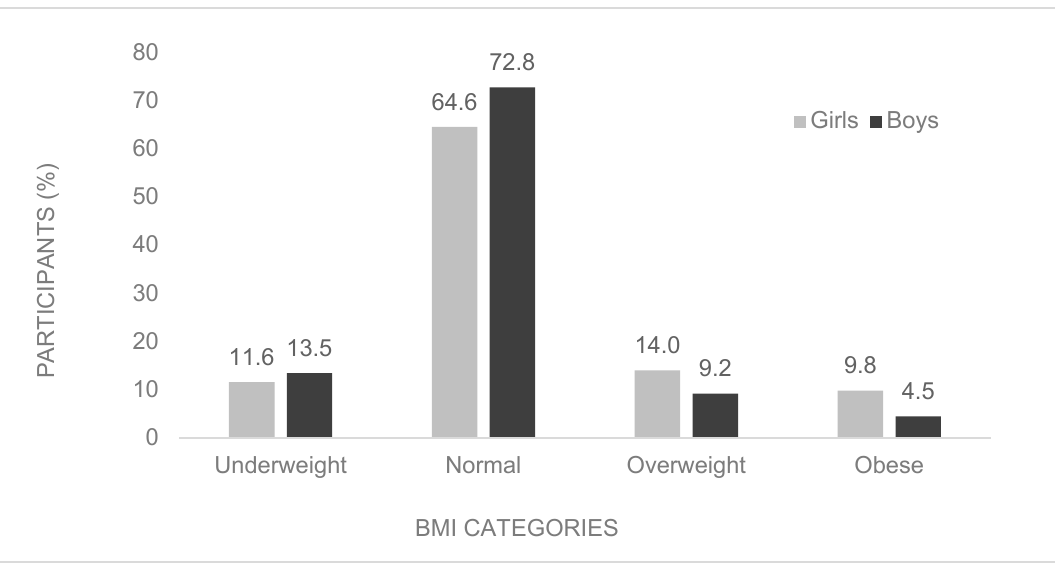
Figure 1. Prevalence of underweight, normal weight, overweight and obese, stratified by sex.